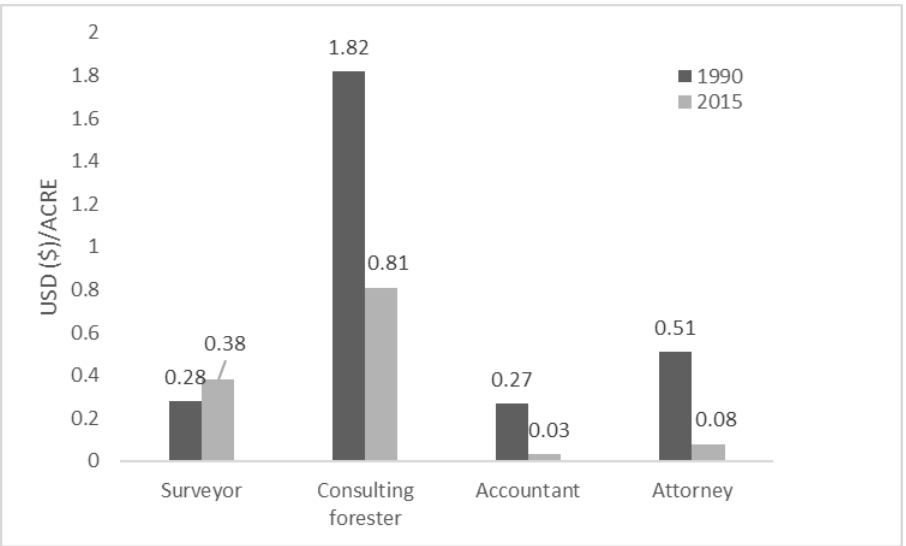
Figure 3. Mean expenditures Fees for Professional Services of the entire sample .